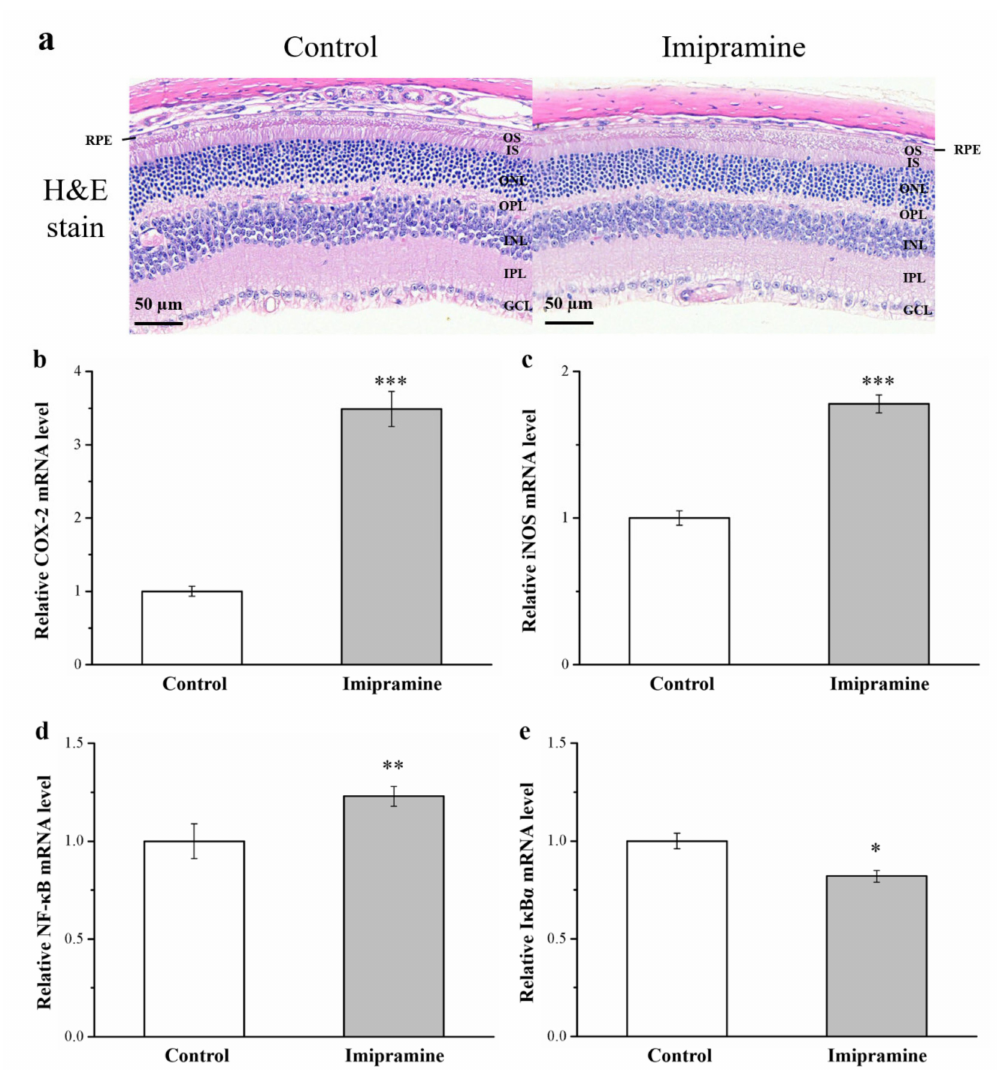
Figure 9. Effects of imipramine on ( a ) retinal morphology according to hematoxylin and eosin staining (magnification, 200 × ). ( b ) Cyclooxygenase-2 (COX-2), ( c ) inducible nitric oxide synthase (iNOS), ( d ) nuclear factor κ B (NF- κ B), and ( e ) inhibitory κ B α (I κ B α ) mRNA levels. Data are in the form of mean ± standard deviation ( n = 8). GCL, ganglion cell layer; IPL, inner plexiform layer; INL, inner nuclear layer; OPL, outer plexiform layer; ONL, outer nuclear layer; IS/OS, inner/outer segment junction; RPE, retinal pigment epithelium. * p < 0.05; ** p < 0.01; *** p <